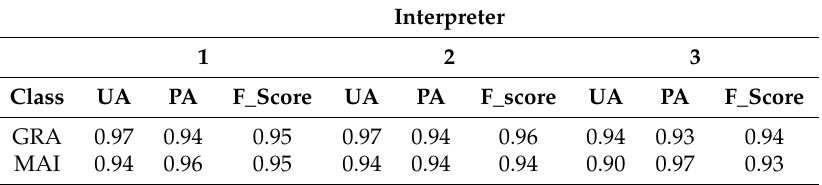
Table 10. Photo-interpretation performance compared to the ground-truth for the 2 main classes.